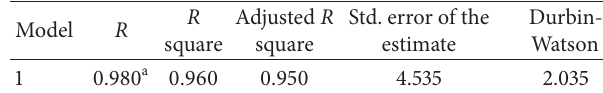
Table 8: Model summary b .